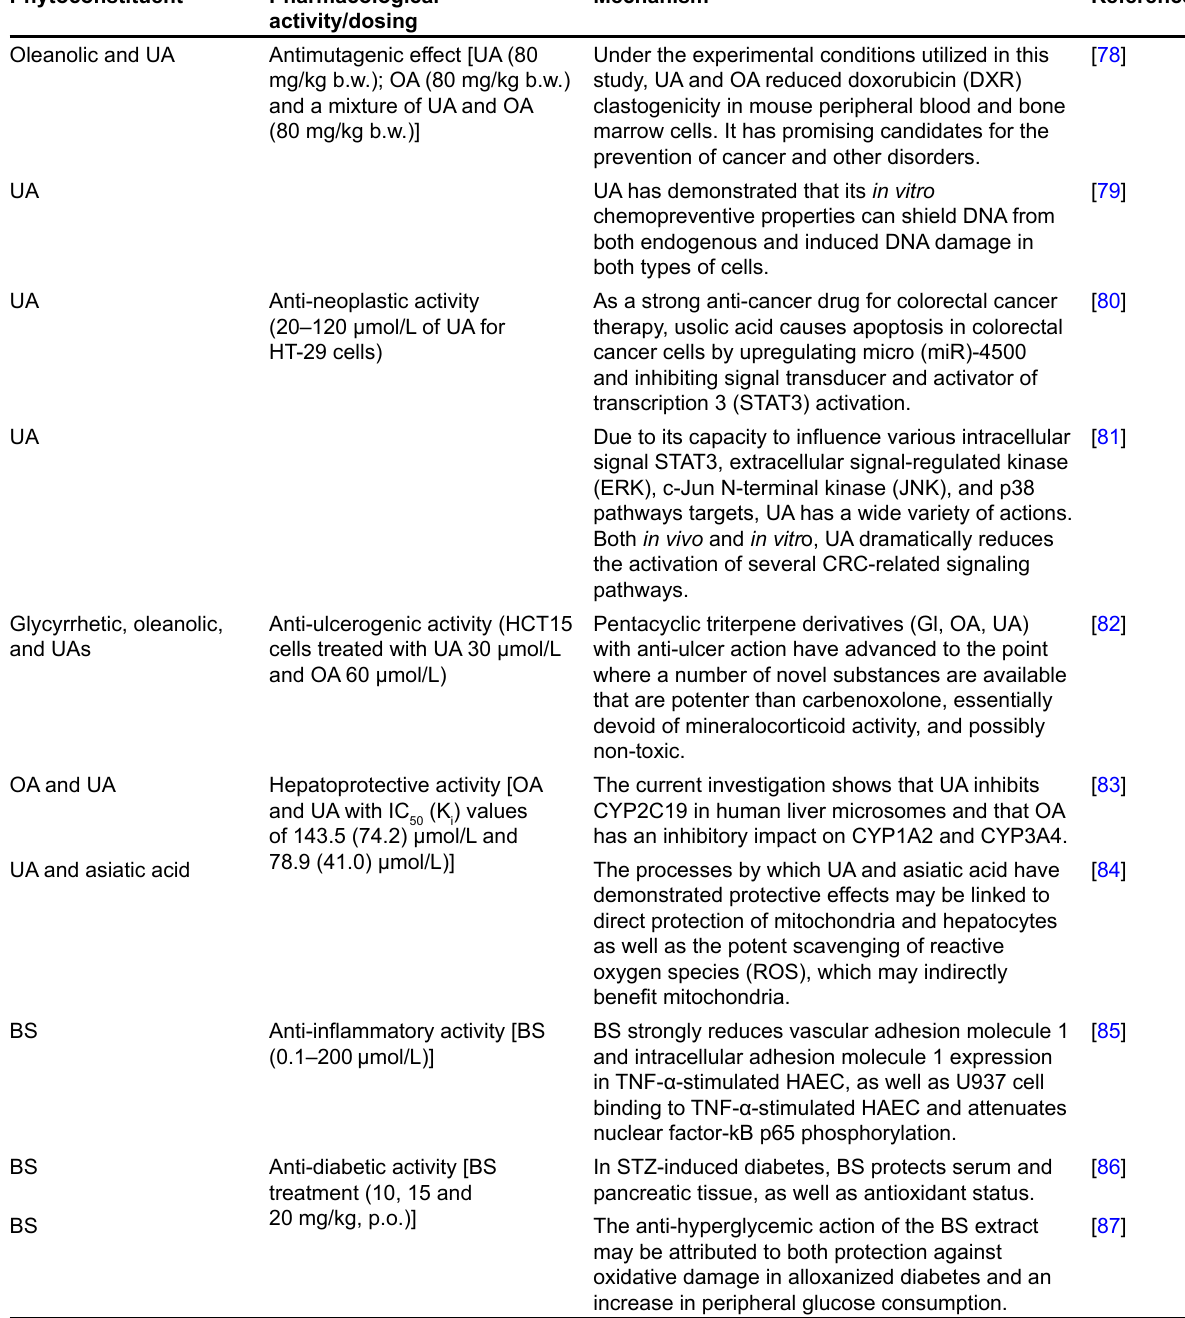
Table 2. Pharmacological activity of phytoconstituents of FA ( continued )